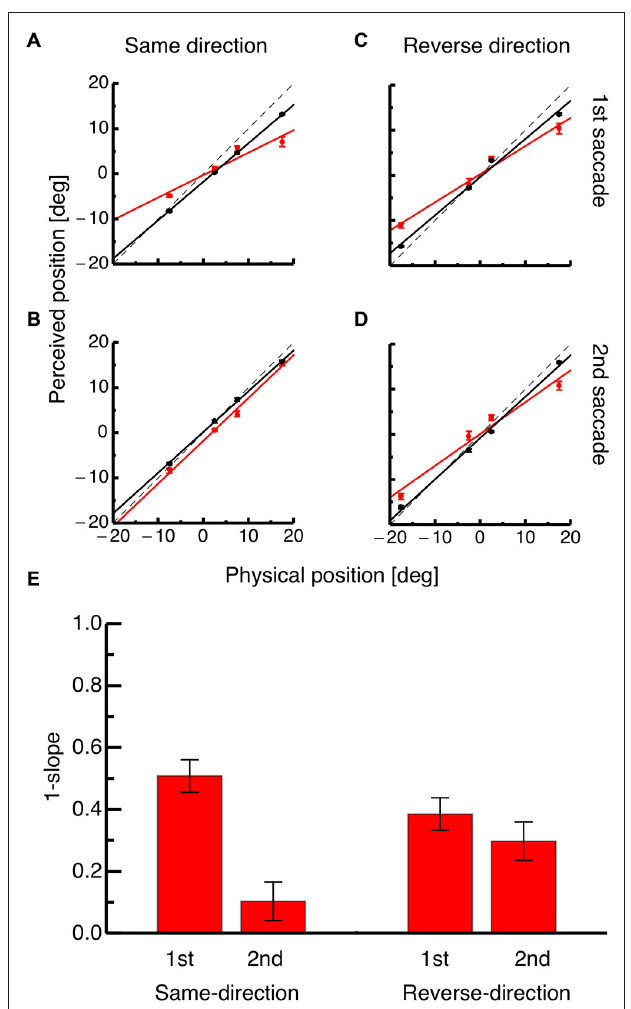
FIGURE 4 | (A) Physical position of the probe dot against perceived position for dots presented immediately at onset of the first saccade (shown in red) and for dots presented at least 100 ms after onset of the first saccade (shown in black) in the same-direction double step paradigm. Lines represent the linear fit of the data (trials averaged across subjects) and error bars represent S.E.M. (B) Physical position of the probe dot against perceived position for dots presented immediately at onset of the second saccade (shown in red) and for dots presented at least 100 ms after onset of the second saccade (shown in black) in the reverse-direction double step paradigm. Same conventions as in (A) . (C) Physical position of the probe dot against perceived position for dots presented immediately at onset of the first saccade (shown in red) and for dots presented at least 100 ms after onset of the first saccade (shown in black) in the reverse-direction double step paradigm. Same conventions as in (A) . (D) Physical position of the probe dot against perceived position for dots presented immediately at onset of the second saccade (shown in red) and for dots presented at least 100 ms after onset of the second saccade (shown in black) in the reverse-direction double step paradigm. Same conventions as in (A) . (E) Average compression indices, reflecting the slope of the regression through average probe localization at the time of saccade onset. Error bars were derived by bootstrapping.